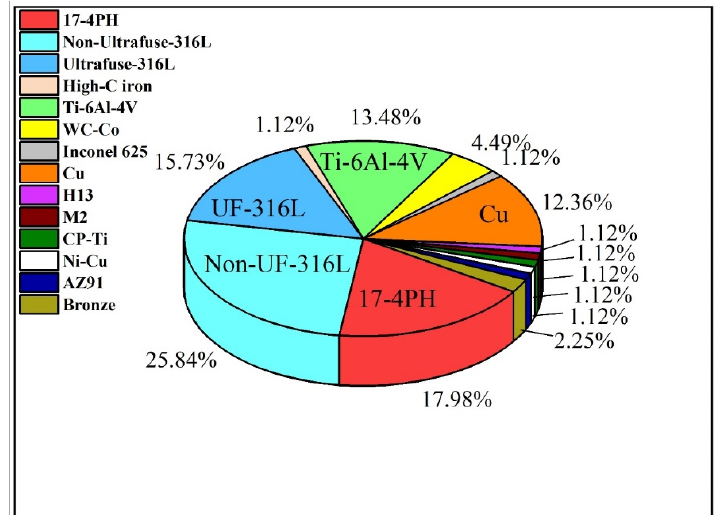
Figure 7. Alloys utilised to fabricate 3D parts by material extrusion additive manufacturing pro- cesses (UF-316L is Ultrafuse-316L and Non-UF-316L is the 316L studies that are fabricated using other filaments). Data from [8,9,29,31,32,34–46,48–53,56,57,59,61,63–68,70,72–76,78,79,81–83,85– Data from